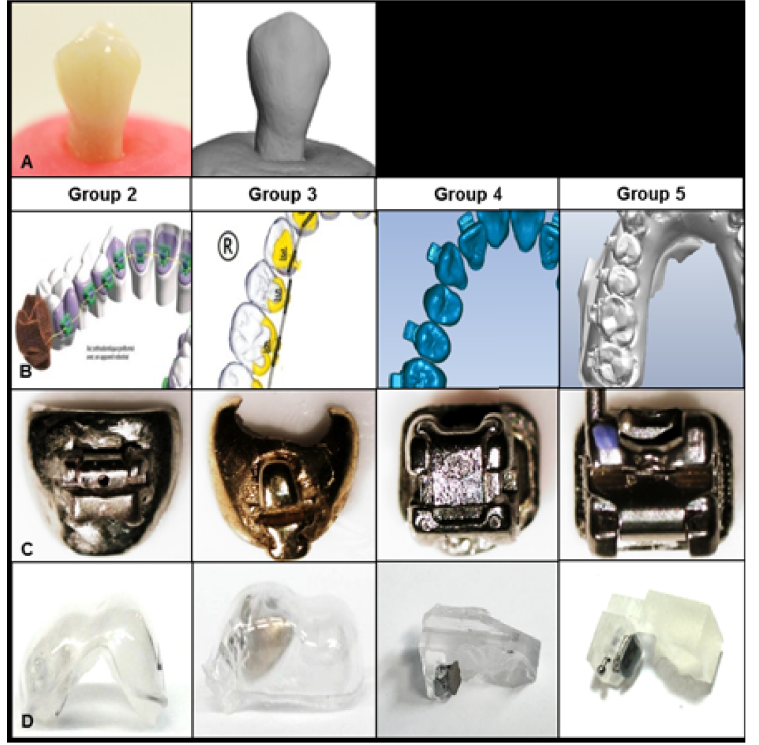
Fig 1. The design and fabrication of customized brackets. A. Scanning and reconstruction of virtual tooth imagine B, Virtual set up and bracket design; C, Bracket fabrication; D, Transfer tray (Groups 2 and 3)/ Transfer jig (Groups 4 and 5). Group 2, Harmony; Group 3, Incognito; Group 4, Insignia; Group 5,